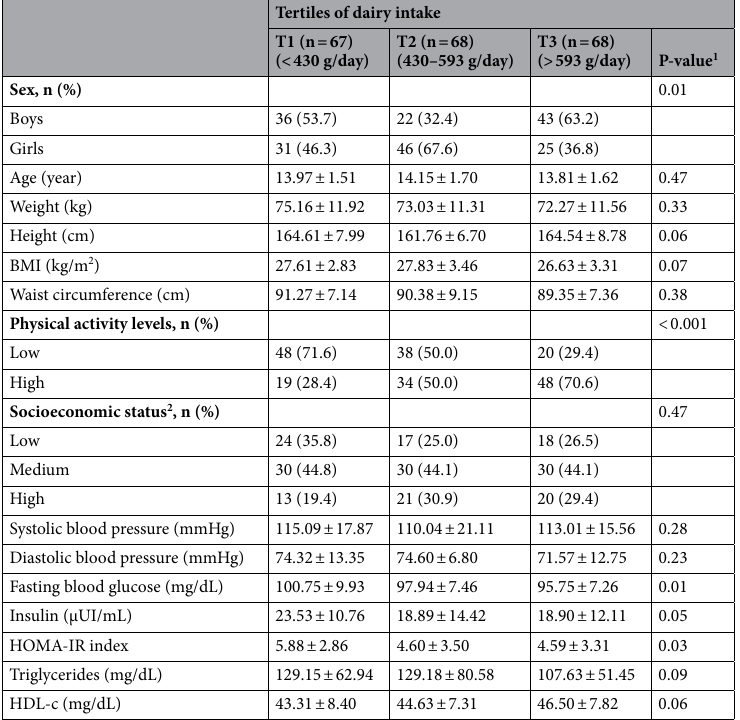
General characteristics and cardiometabolic factors of study participants across energy-adjusted tertiles of dairy intake are summarized in Table 1. Participants with the highest dairy intake (tertile 3) were more likely to be boys (P = 0.01), and physically active (P < 0.001) compared to those in the lowest tertile. Additionally, the mean FBG (P = 0.01) and HOMA-IR index (P = 0.03) were significantly lower among adolescents in the highest tertile in comparison to those in the lowest one. However, no significant difference was observed regarding other general or cardiometabolic features across tertiles of dairy intake. General characteristics and cardiometabolic factors of adolescents across energy-adjusted tertiles of dairy intake, stratified by sex are shown in the Supplemental Table 1. Both girls and boys in the highest tertile of dairy intake were more likely to be physically active. In addition, the mean FBG was significantly lower in subjects in the highest category of dairy intake in both genders (P < 0.05). Dietary intakes of study participants across energy-adjusted tertiles of dairy intake, stratified by sex are presented in the Supplemental Table 2. In both groups, no significant difference was observed in energy intake across tertiles of dairy intake (P > 0.05). However, girls in the third tertile of dairy intake had a significantly higher intake of protein, cholesterol, saturated fatty acid (SFA), vitamin C, vitamin A, riboflavin, vitamin B6, folate, vitamin B12, magnesium, calcium, and total fiber (P < 0.05), while no significant difference was observed between dietary intake of poly-unsaturated fatty acid (PUFA), thiamin, niacin, and vitamin E across tertiles of dairy intake among girls (P > 0.05). Furthermore, boys in the third tertile of dairy intake had a significantly higher intake of protein, fat, cholesterol, SFA, monounsaturated fatty acid (MUFA), vitamin C, vitamin A, riboflavin, vitamin B6, folate, vitamin E, magnesium, calcium, total fiber and lower intake of carbohydrates, thiamin, and niacin (P < 0.05). No significant difference was observed between dietary intake of PUFA and vitamin B12 across tertiles of dairy intake among boys (P > 0.05). The distribution of adolescents with MUO phenotype across energy-adjusted tertiles of dairy intake is pre- sented in Fig. 1. Based on IDF definition, 52.2%, 44.1%, and 20.6% of individuals were identified as MUO in (P < 0.001).